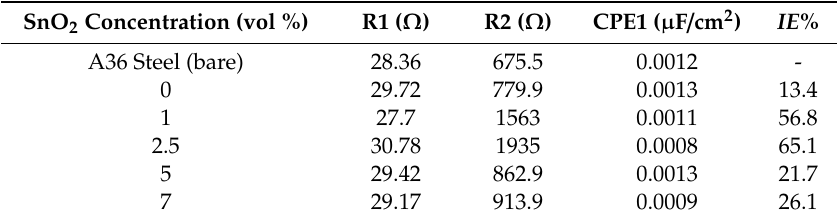
Table 4. The corrosion parameters obtained from EIS.